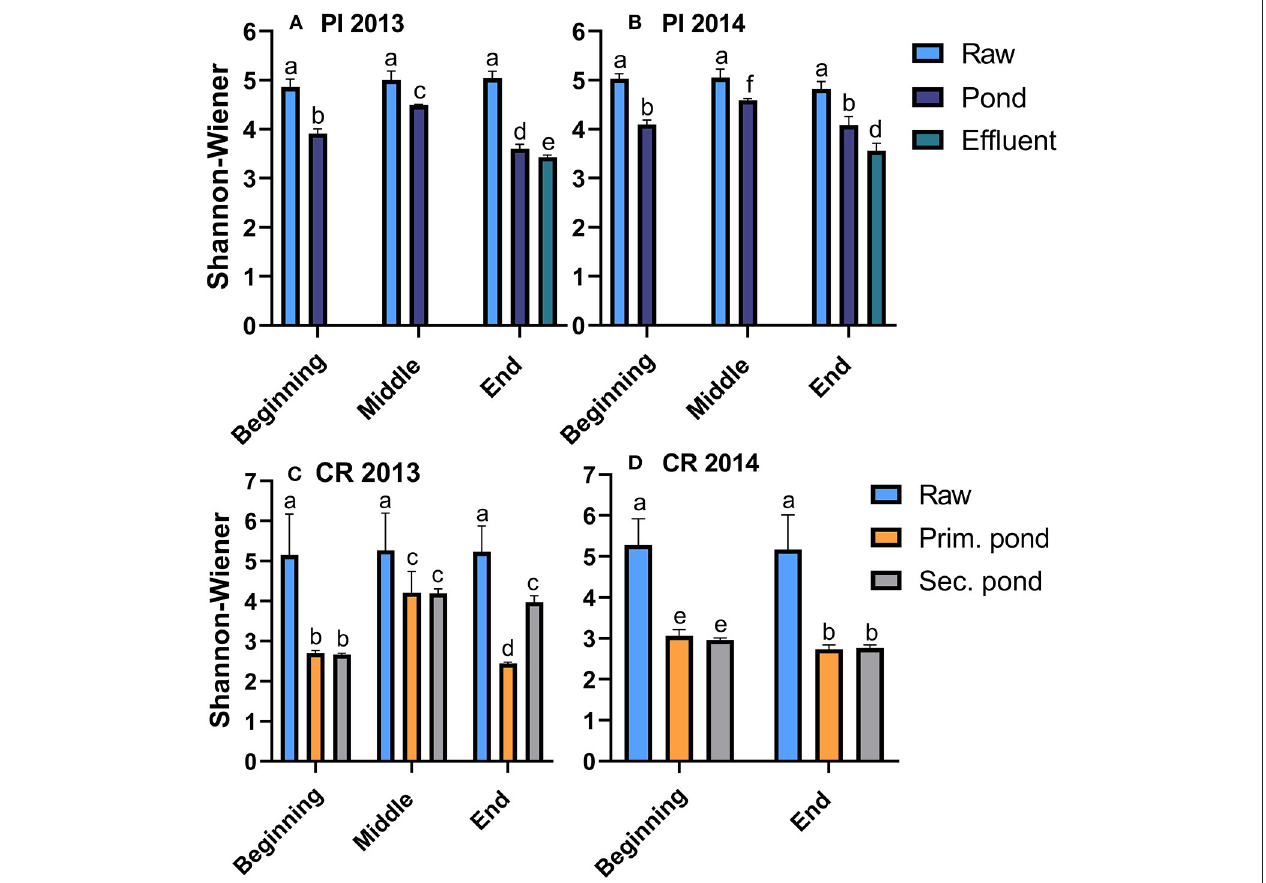
FIGURE 2 | Alpha diversity (Shannon-Wiener Index) in raw and treated wastewater samples from Pond Inlet [PI, (A,B) ] and Clyde River [CR, (C,D) ] in 2013 and 2014. Bars with different letters within the same community are significantly ( p < 0.05) different from each other.